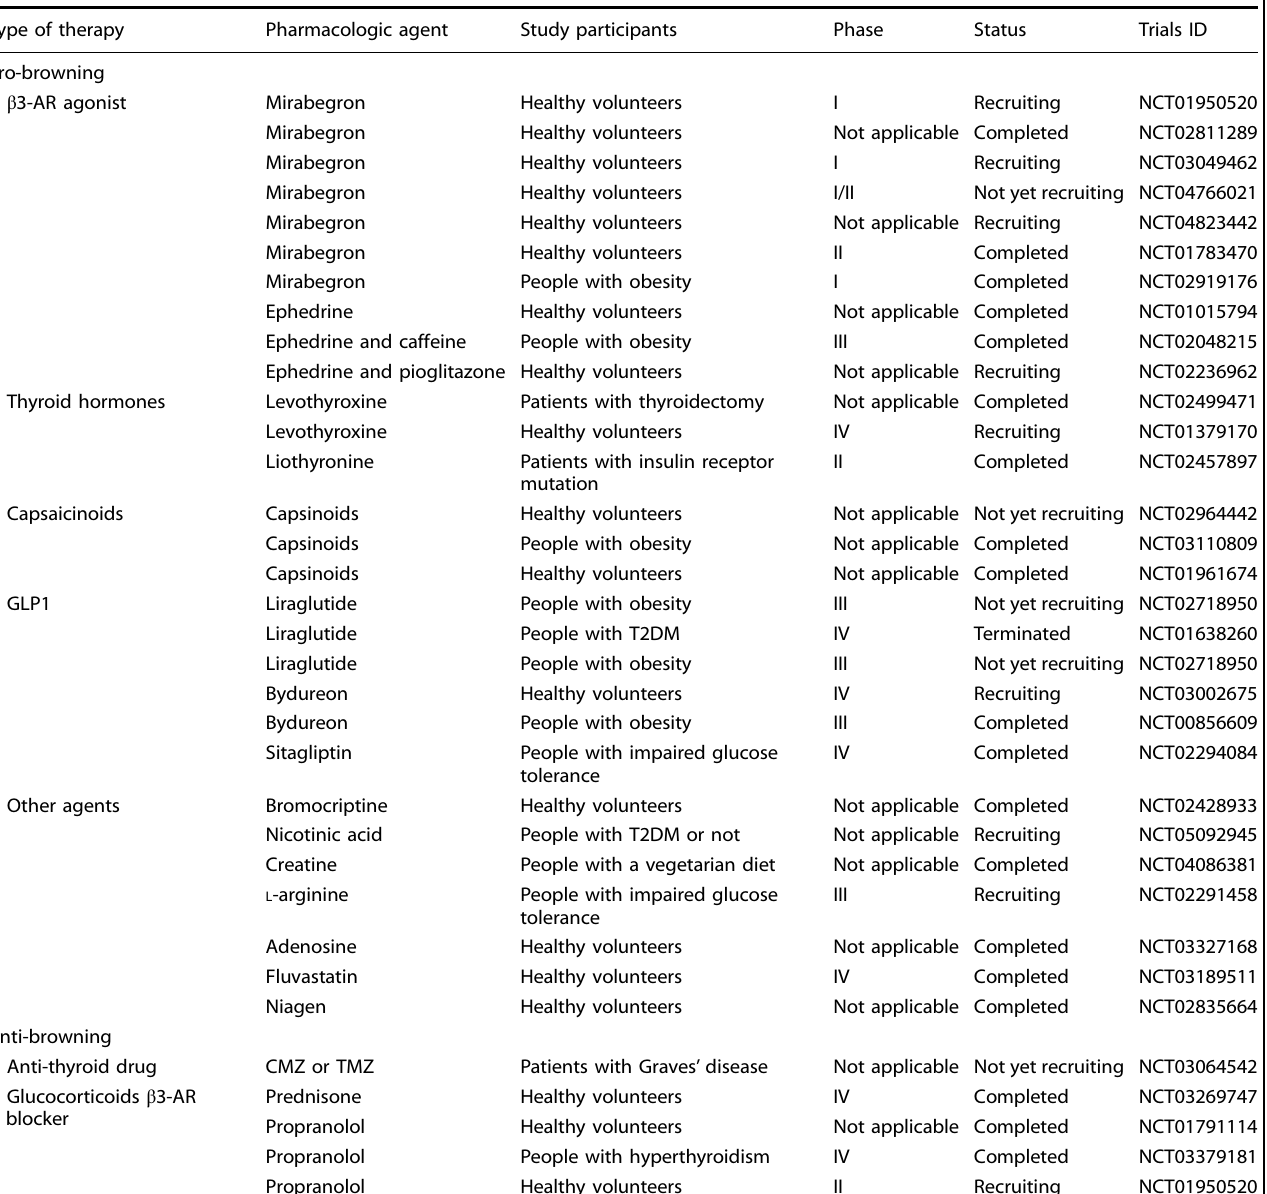
Table. 2. Current clinical trials targeting activation or inhibition of thermogenic fat in